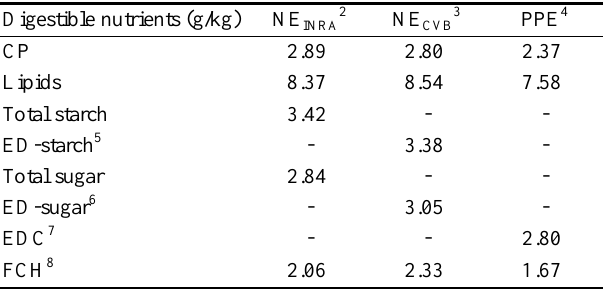
Table 4. Coefficients in prediction equations of European energy systems 1 Digestible nutrients (g/kg)